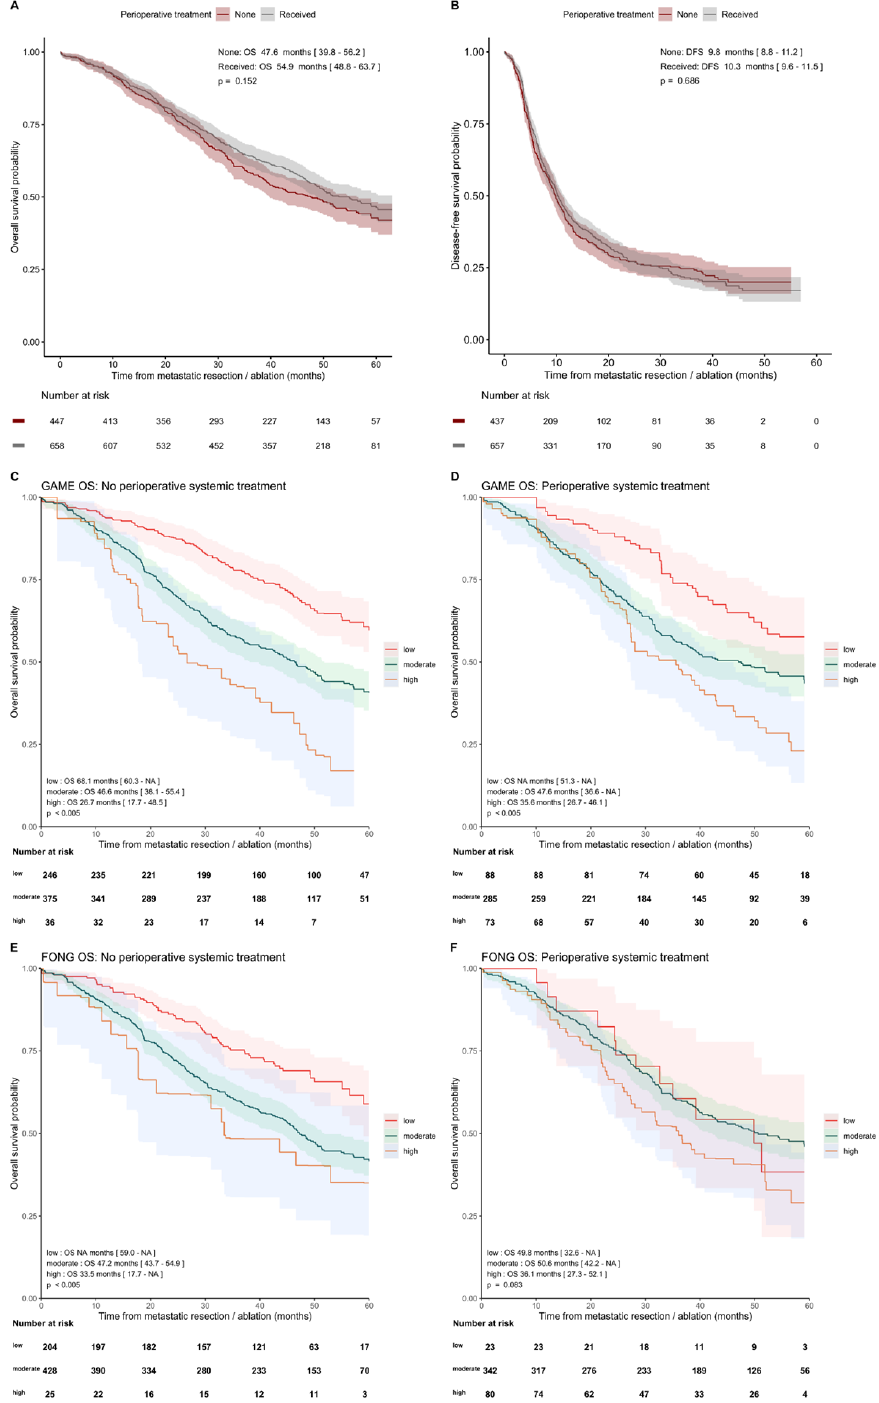
Figure 3. Kaplan–Meier analysis showing OS and DFS curves in patients with and without periop- erative systemic therapy for the GAME and Fong risk categories. ( A ) OS and ( B ) DFS in patients with and without perioperative systemic therapy. OS outcomes of the GAME risk categories were analyzed in the subgroup without ( C ) and with perioperative systemic therapy ( D ) and OS outcomes of the Fong risk categories in subgroups of patients without ( E ) and with perioperative systemic therapy ( F